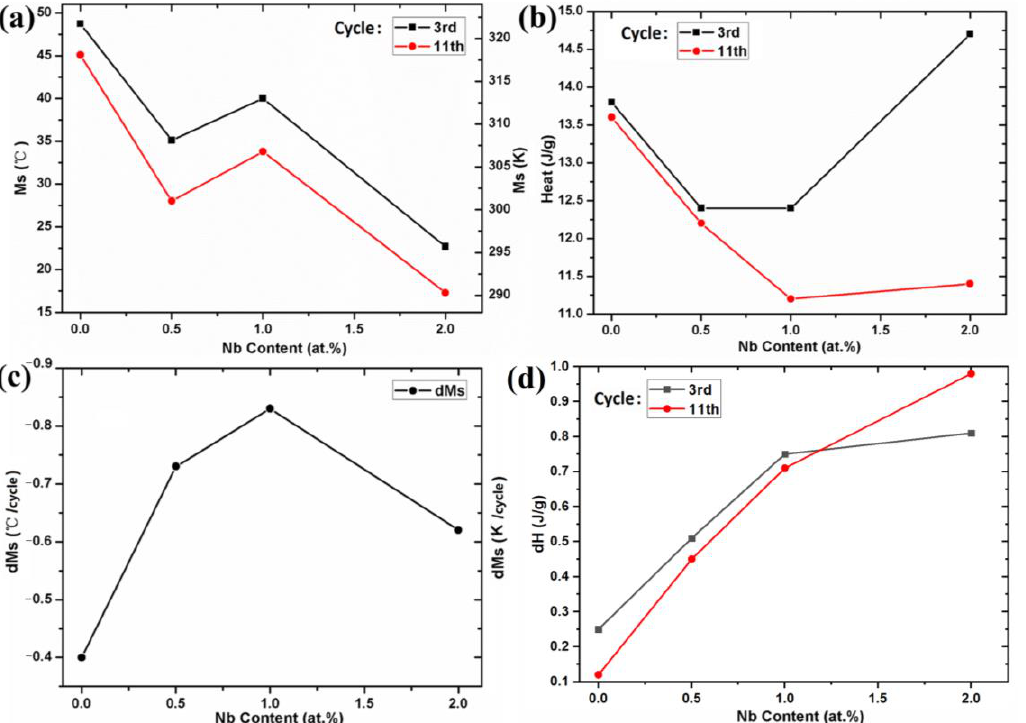
Figure 6. Transformation behaviour of Ti 41 − 0.5x Ni 39 − 0.5x Cu 10 Hf 10 Nb x SMA: ( a ) influence of Nb content and thermal cycles (the third cycle is indicated by the black line and the eleventh cycle is red line) on M s temperature; ( b ) influence of Nb content and thermal cycles on transformation heat; ( c ) influence of Nb content on the reduction of M s per thermal cycle; ( d ) influence of Nb content and thermal cycles on the transformation heat difference between austenite transformation and MT.